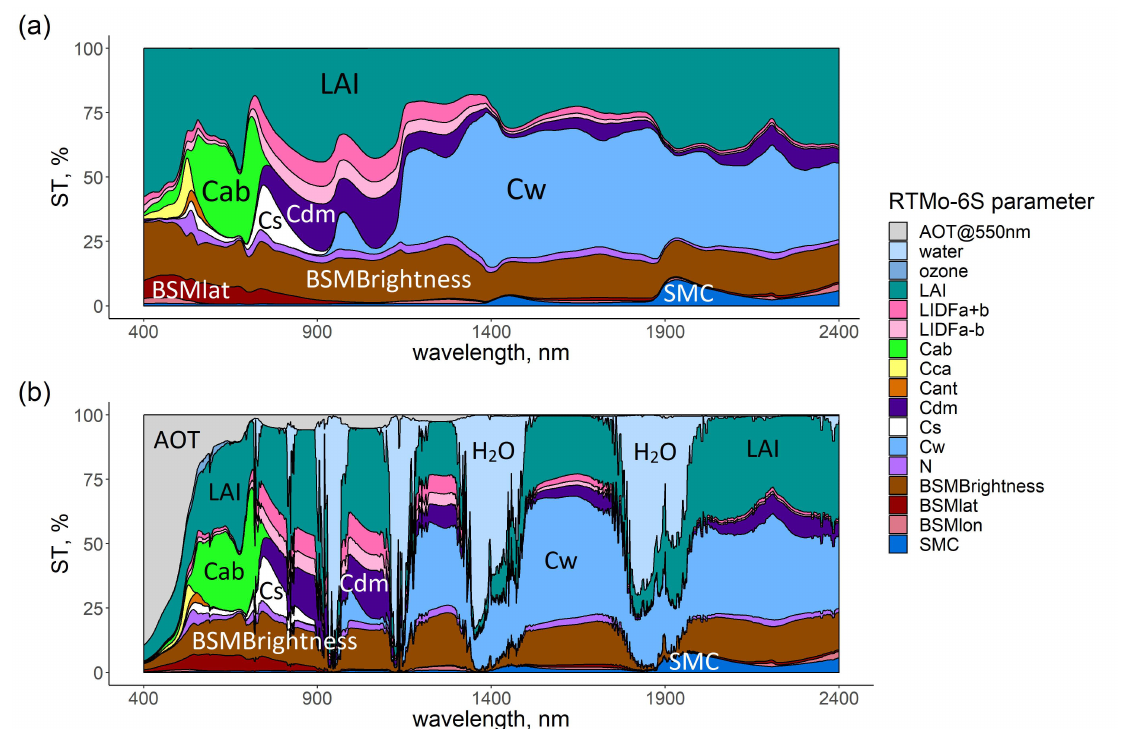
Figure 4. Total order sensitivity indices (ST) calculated with coupled RTMo-6S model in the range 400–2400 nm. ( a )—top of canopy (TOC), ( b )—top of atmosphere (TOA). ST are expressed in percentages. Definitions of parameters can be found in Table